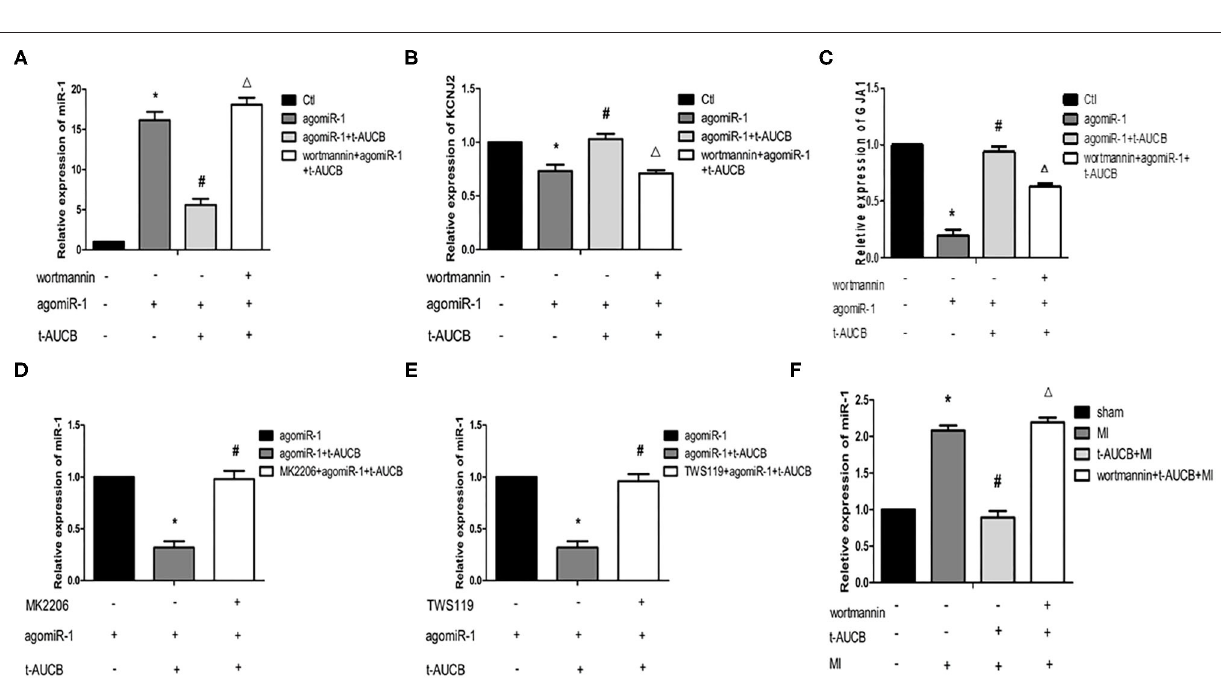
FIGURE 2 | SEHis regulate miR-1 by acting on the PI3K/Akt/GSK3 β pathway. PI3K, Akt, and GSK3 β inhibitors, and t-AUCB were used to treat mouse cardiomyocytes overexpressing microRNA-1 (miR-1) and mice with myocardial infarction (MI). Real-time quantitative PCR tested the relative mRNA expressions of miR-1 and its target genes. (A) Wortmannin (inhibitor of PI3K) reversed the negative regulation of miR-1 by t-AUCB in neonatal mouse cardiomyocytes ( n = 4). (B) Wortmannin reversed the effect of t-AUCB on KCNJ2 ( n = 4). (C) Wortmannin reversed the effect of t-AUCB on GJA1 ( n = 4). (D) MK2206 (inhibitor of Akt) inhibited the effect of t-AUCB on miR-1 ( n = 6). (E) TWS119 (inhibitor of GSK3 β ) increased miR-1 levels ( n = 6). (F) Effect of wortmannin on miR-1 in ischemic myocardium of mice after t-AUCB intervention ( n = 4). Compared with the control (Ctl) group, * P < 0.05; compared with the agomiR-1 group, # P and * P < 0.05; compared with the agomiR-1 + t-AUCB group, 1 P and * P <